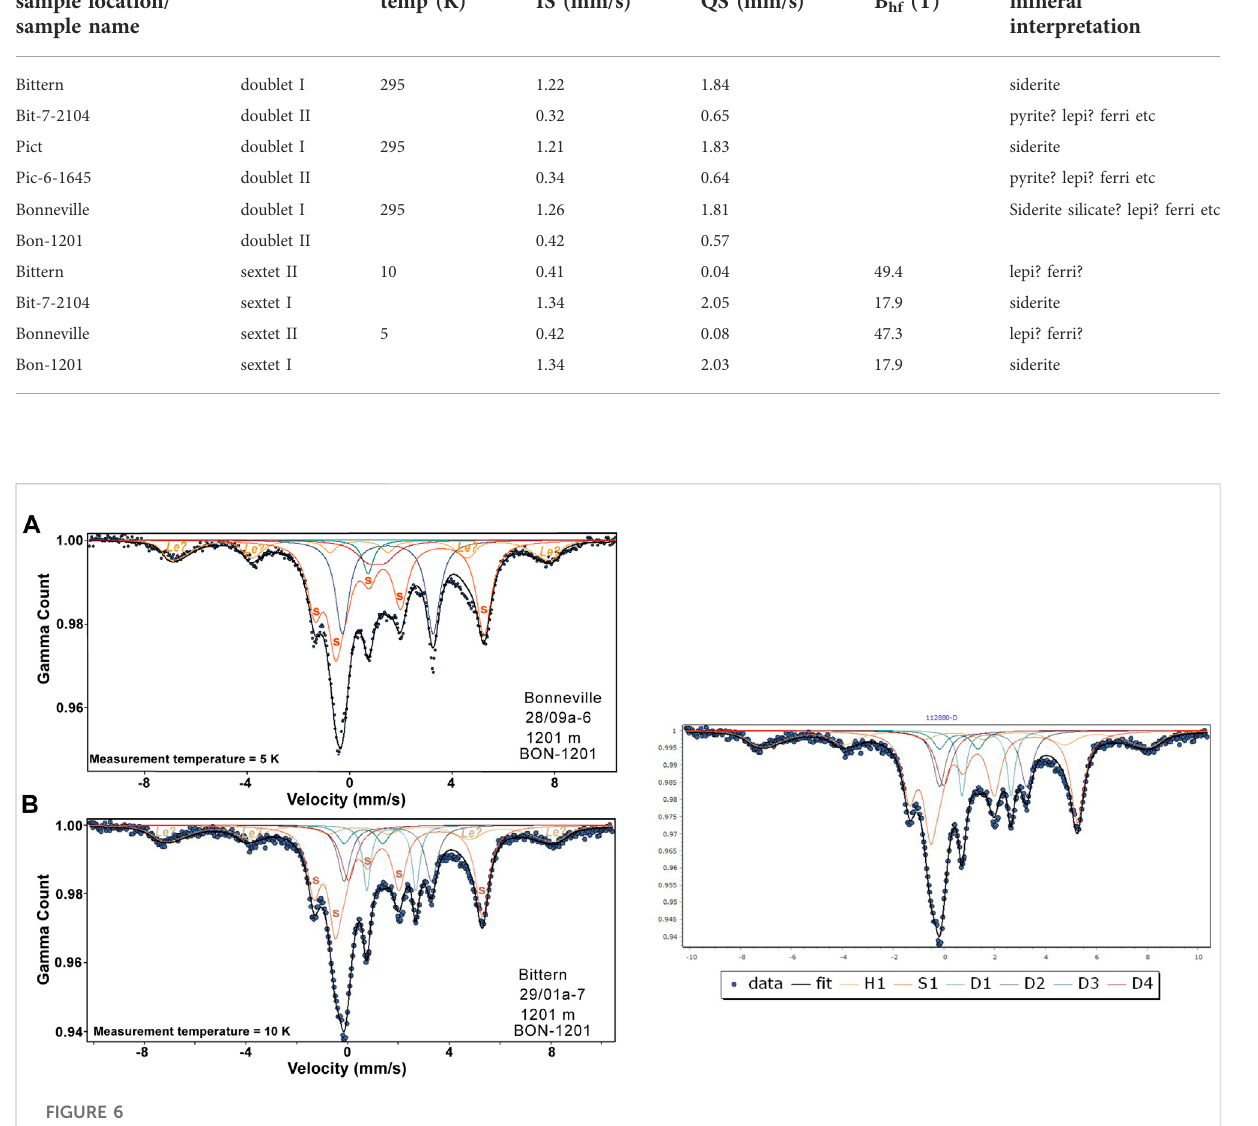
FIGURE 6 LowtemperatureMössbauer spectra measuredfor [ (A) Bonnevilleand (B) ]Bitternsamplesatthe contact. Two sextets suggesting thepresence of siderite (s) and lepidocrocite/ferrihydrite are present. The latter sextet is interpreted as indicating lepidocrocite (Le) due to supporting high temperature susceptibility